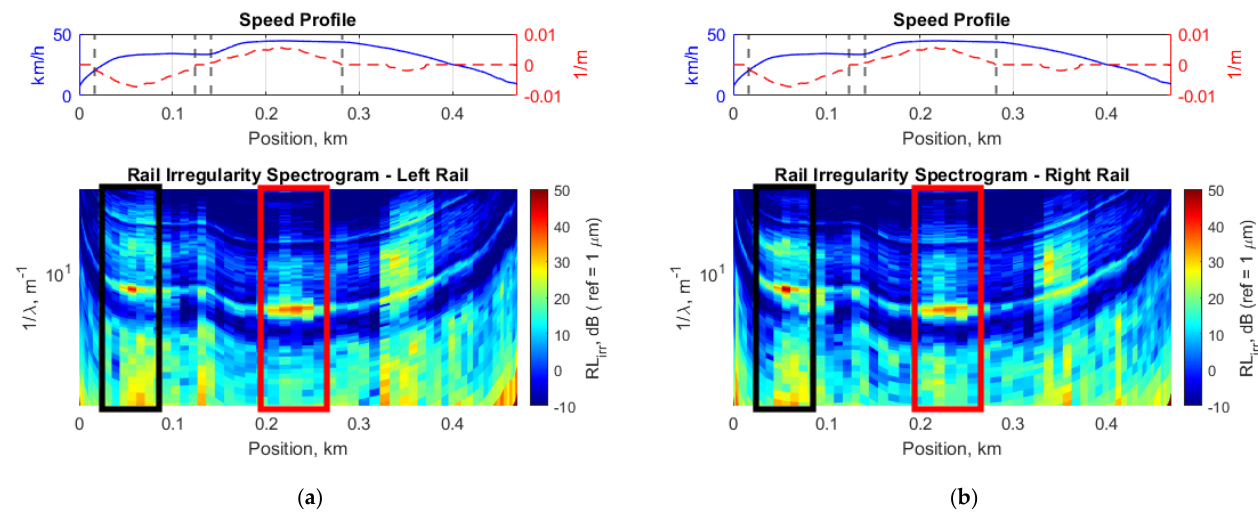
Figure 11. Spectrogram of the rail irregularity on Day 1, along with the vehicle speed (solid line) and the horizontal curvature of the track (dashed line): ( a ) left rail; ( b ) right rail.